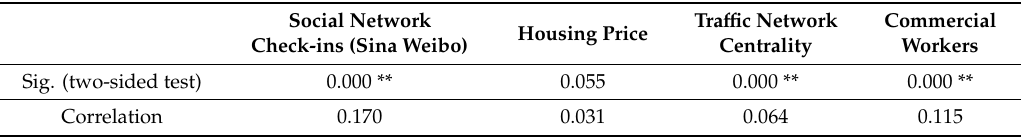
Table 3. The Spearman correlation analysis—Sig. (two-tailed) and correlation coe ffi cient between the operation cost of digital signage and four